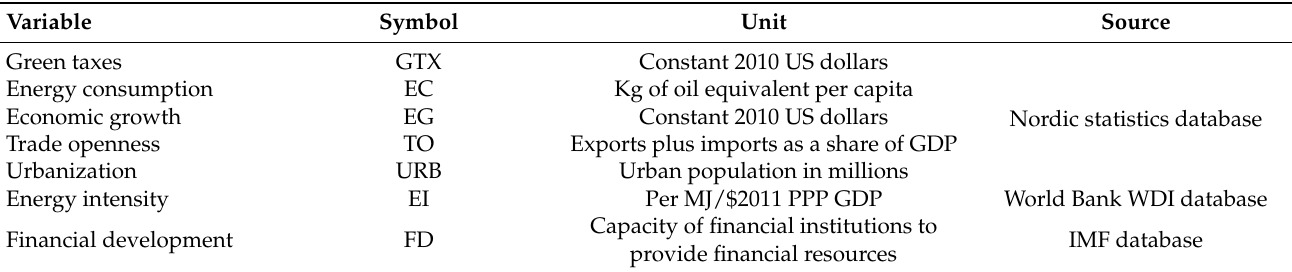
Table 1. Description of the